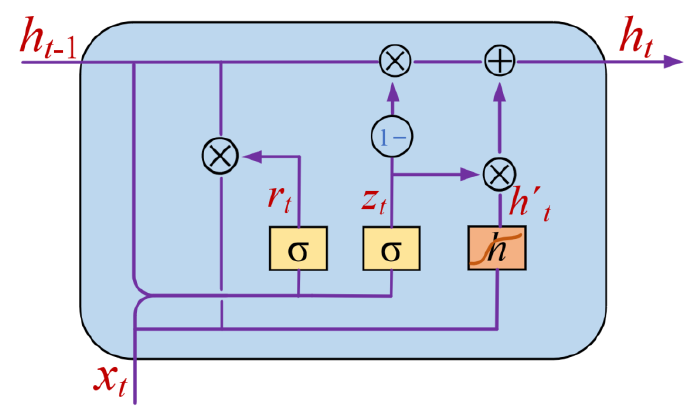
Figure 4. The structure of GRU.